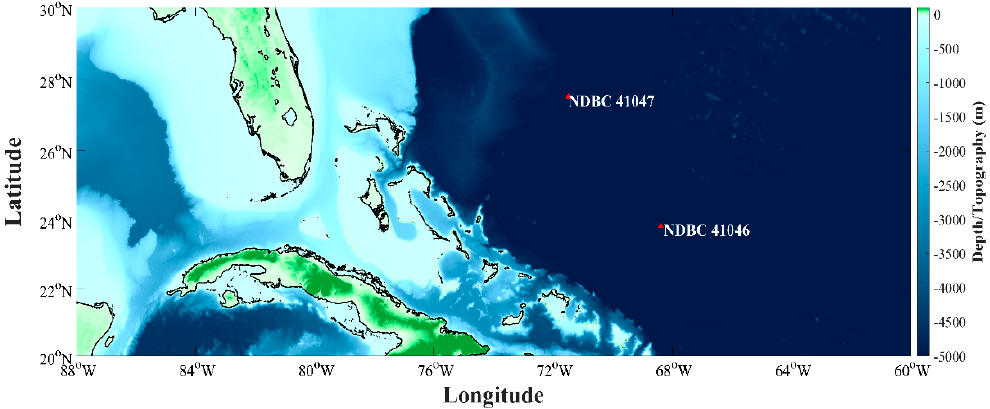
Figure 1. Locations of National Data Buoy Center buoys 41046 and 41047. Table 1. Selected National Data Buoy Center buoys and their relevant statistics. Data range from 1 January 2018–31